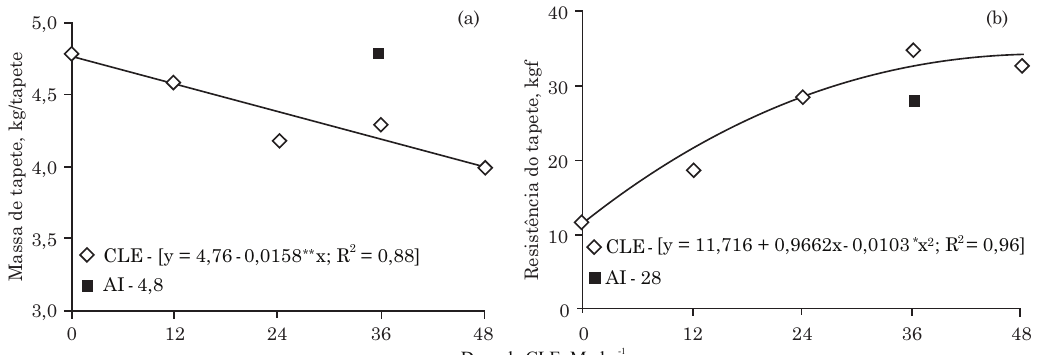
Figura 7. Massa (a) e resistência de tapetes (b) da grama Imperial em função de doses de composto de lodo de esgoto (CLE) e da adubação inorgânica (AI), aos 13 meses após a aplicação do